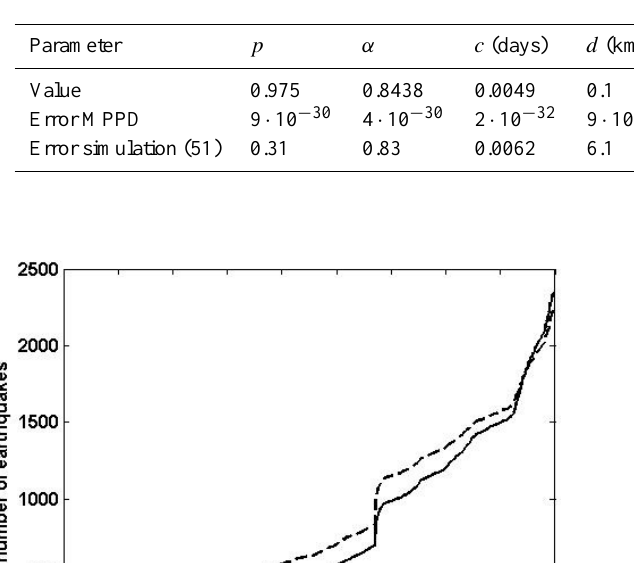
Table 1. Average values and error of the ETAS fit for magnitude higher than 1.